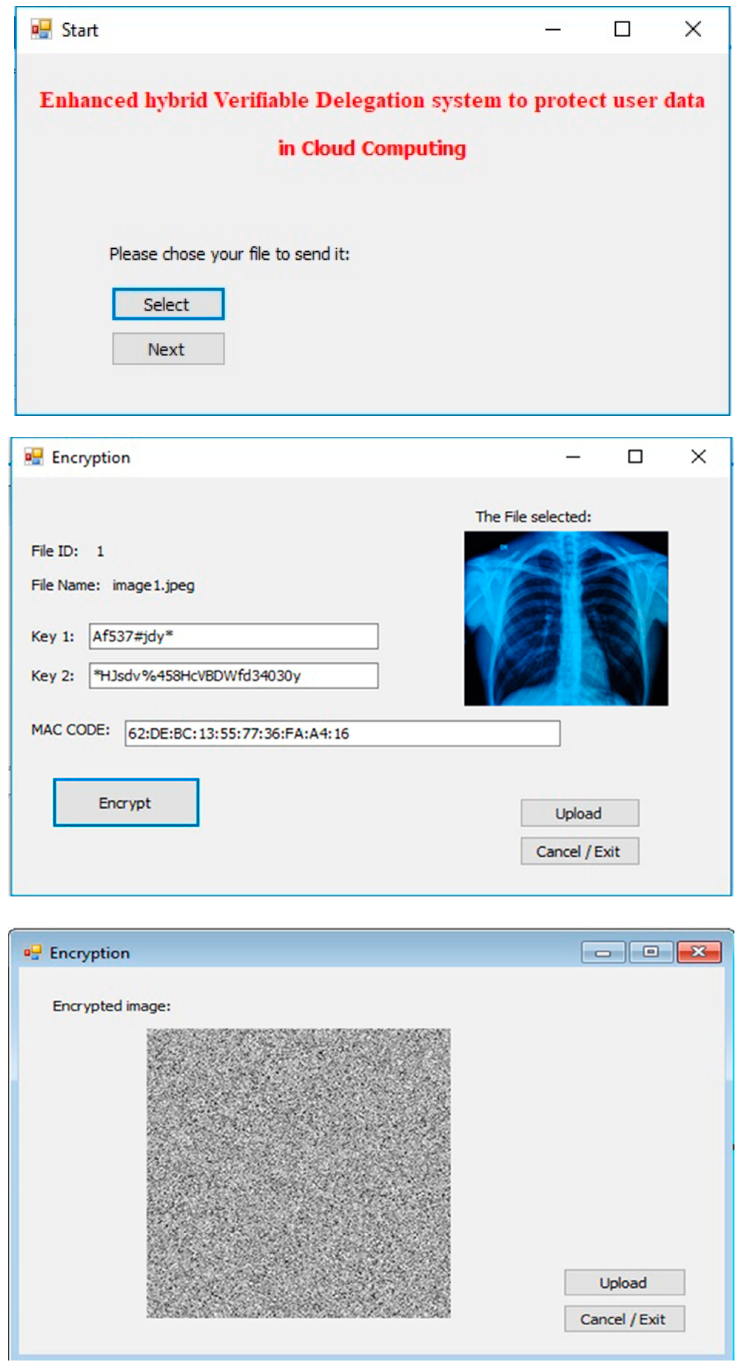
Figure 7. Selected file and encrypted image.